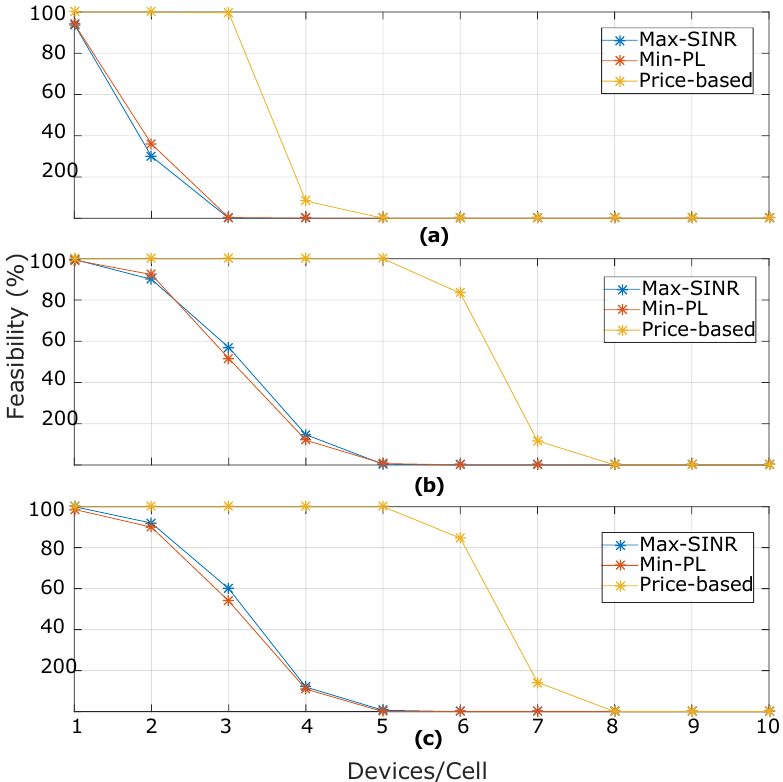
Figure 4. Feasible solutions (%) found by each algorithm under different backhaul capacity configurations ( a ) 4 Mbps, ( b ) 12 Mbps, and ( c ) 21 Mbps. The R min c requirement is assumed to be 250 Kbps for human-type communication devices (HTC) devices and R min type communication (MTC)